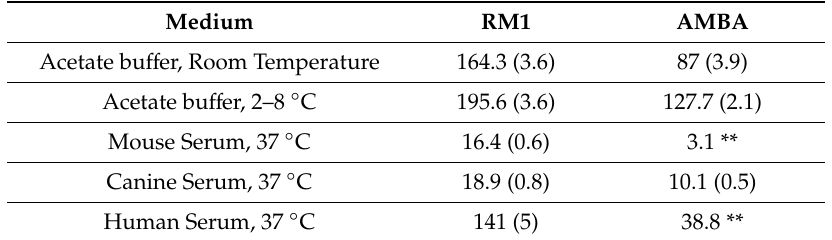
Figure 7. A plot of percent remaining of 177 Lu-Labeled RM1, in human (circles), canine (triangles), and mouse sera (squares) at 37 °C, as a function of time. Table 2. Summary of half-life of degradation (h) of 177 Lu-Labeled RM1 and AMBA in acetate buffer, mouse, canine, and human sera.